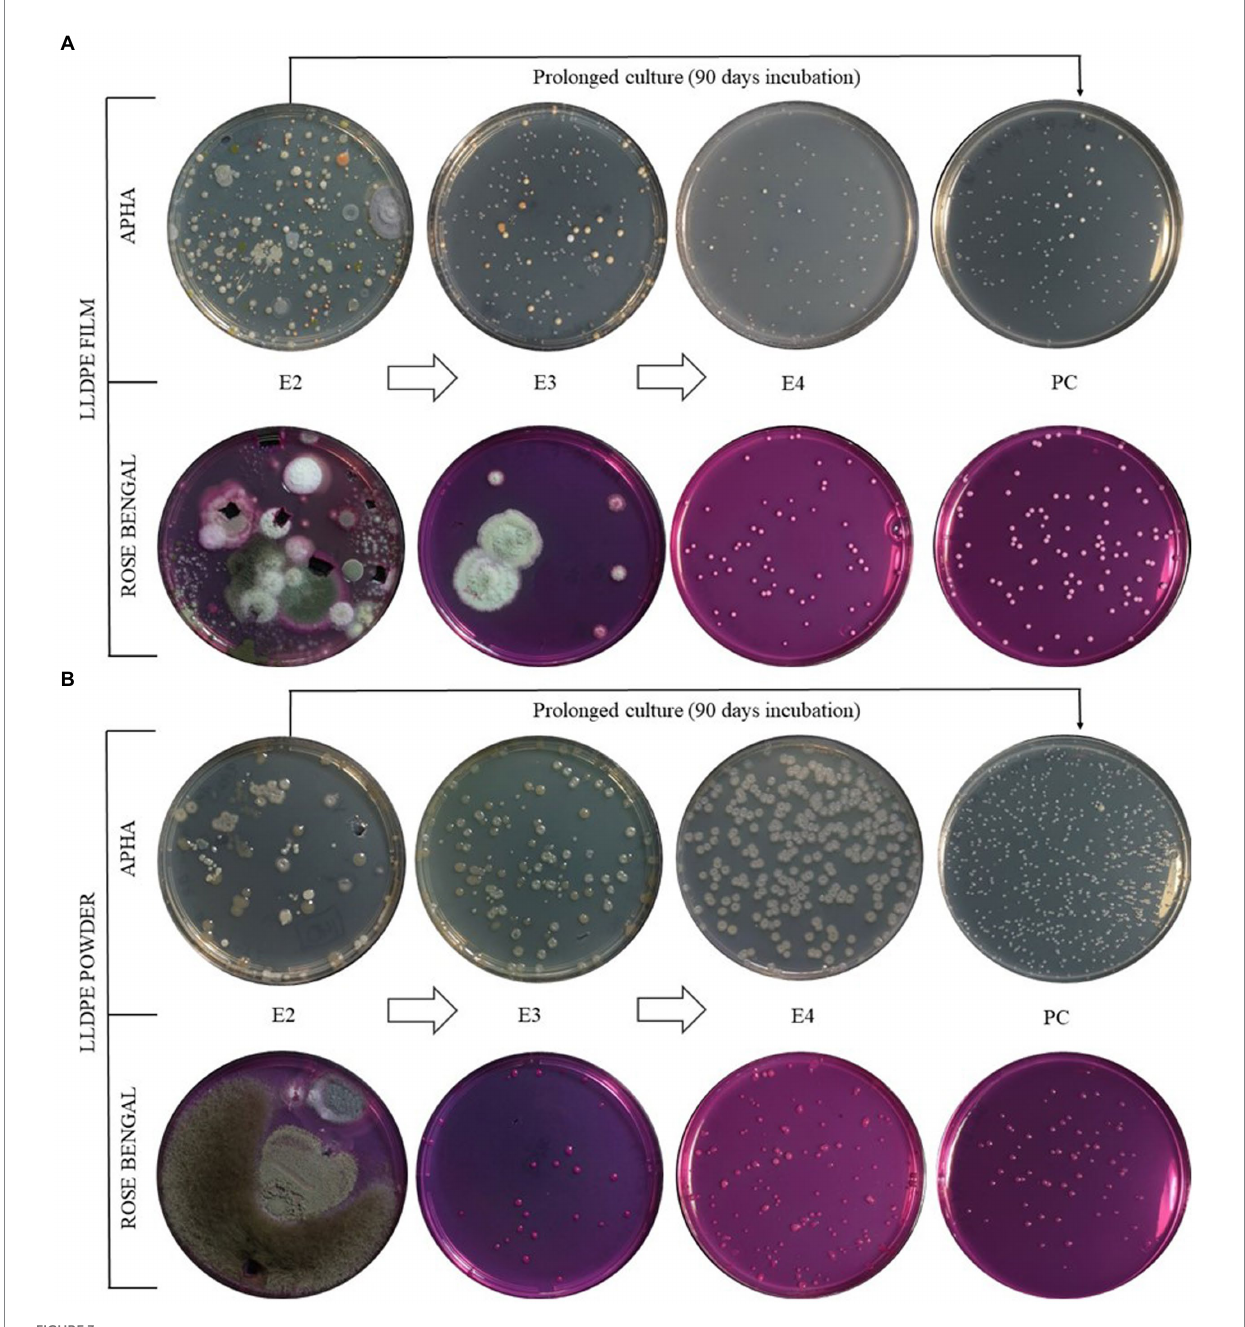
FIGURE 3 Colonial morphotypes comparison between sequential enrichment with LLDPE film (A) and powder (B) . From top down, bacterial (NA medium) and fungal (Rose Bengal medium) morphotypes. E1, E2, E3 and E4: Enrichments 1, 2, 3 and 4; PC: Prolonged